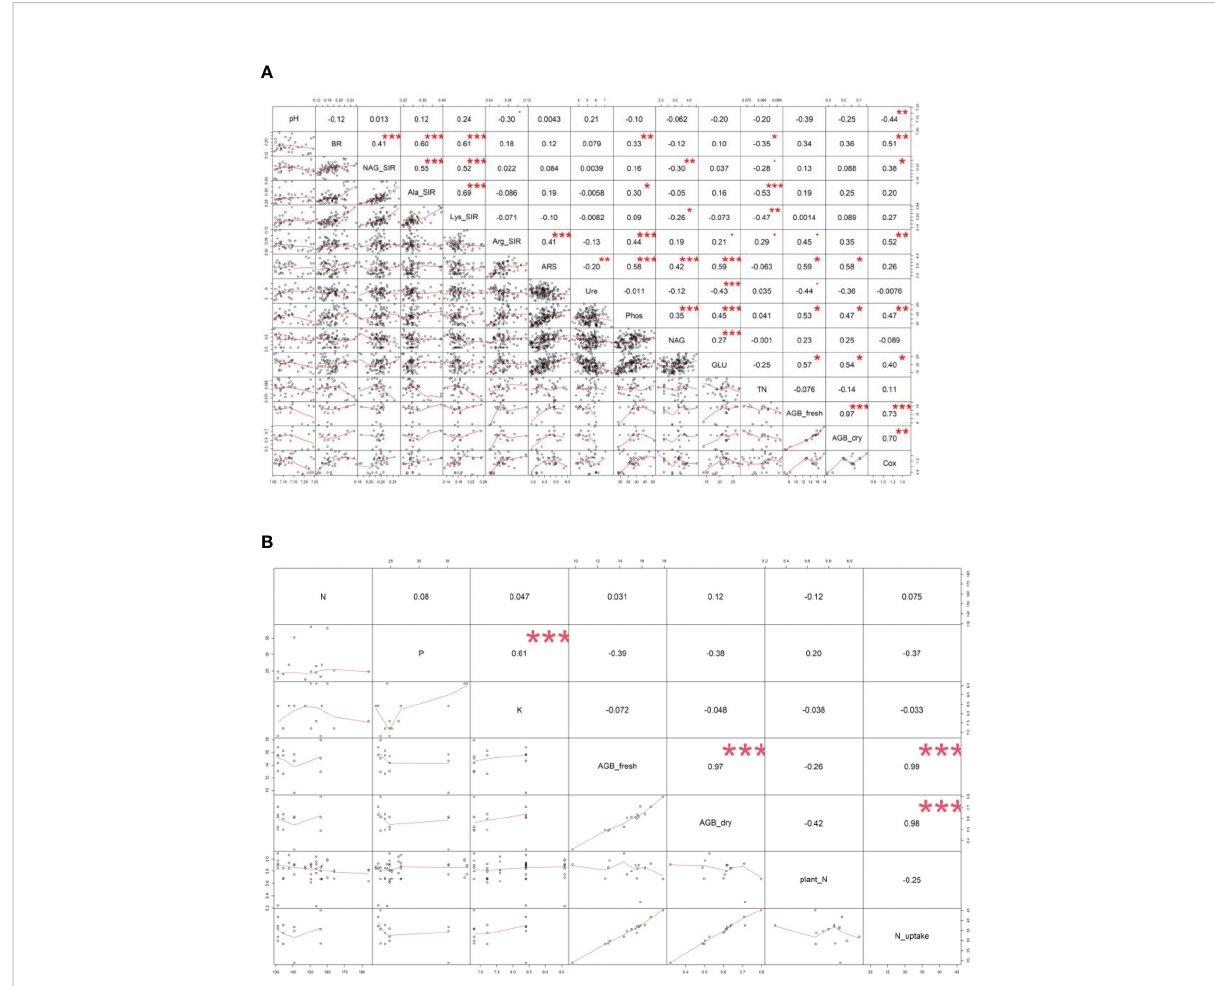
FIGURE 4 Pearson ’ s correlation analysis – values of correlation coef fi cient (r) between (A) soil and plant properties, (B) digestate (N, P, K content) and plant properties of all variants. Displayed correlation coef fi cients (r) were calculated on the statistical level of signi fi cance: * p ≤ 0.05, ** p ≤ 0.01, *** p ≤ 0.001. Fresh (AGB_fresh) and dry (AGB_dry) aboveground plant biomass, soil pH, total nitrogen (TN), total oxidizable carbon (Cox), basal (BR) and substrate-induced respirations - N-acetyl- b -D-glucosamine (NAG_SIR), L-alanine (Ala_SIR), L-lysine (Lys_SIR) and L-arginine (Arg_SIR), enzyme activities - urease (Ure), arylsulfatase (ARS), N-acetyl- b -D-glucosaminidase (NAG), b -glucosidase (GLU), phosphatase